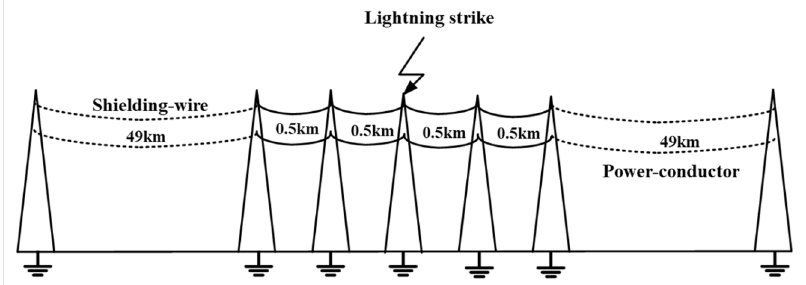
Figure 3. Model of the distributed-parameter 100 km DC transmission line.